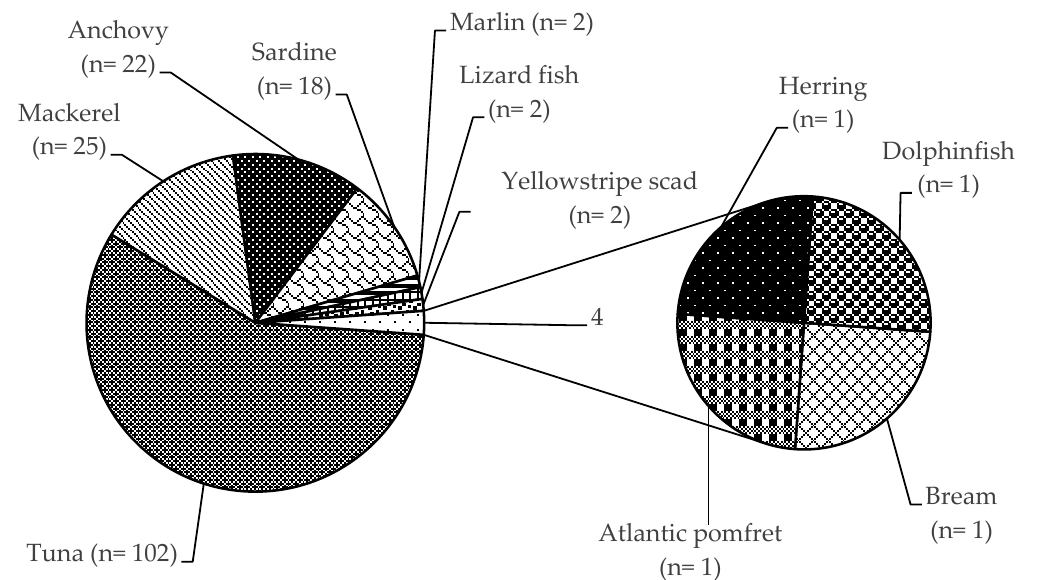
Figure 3. Distribution of histamine in fish species according to the Rapid Alert System for Food and Feed (RASFF) from 1 January 2015 to 31 August 2020.